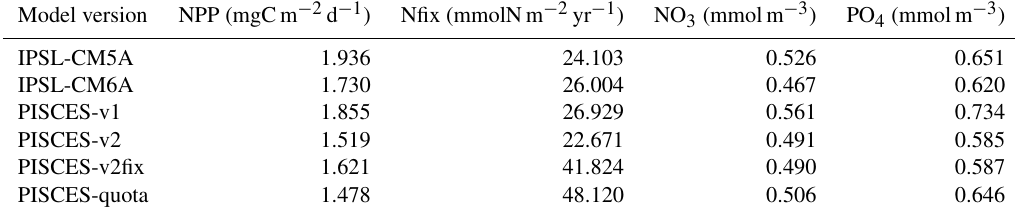
Table 2. Root-mean-square errors (RMSEs) for NPP (mgCm − 2 d − 1 ), N fixation (Nfix, mmolNm − 2 yr − 1 ), and NO 3 and PO 4 surface concentrations (mmolm − 3 ) for all PISCES versions used here against observations (NPP based on remote-sensing – Behrenfeld et al., 2005; N fixation from Luo et al., 2014, updated by Landolfi et al., 2018; and NO 3 and PO 4 as provided in the World Ocean Atlas database – Garcia et al., 2013). All model estimates are for